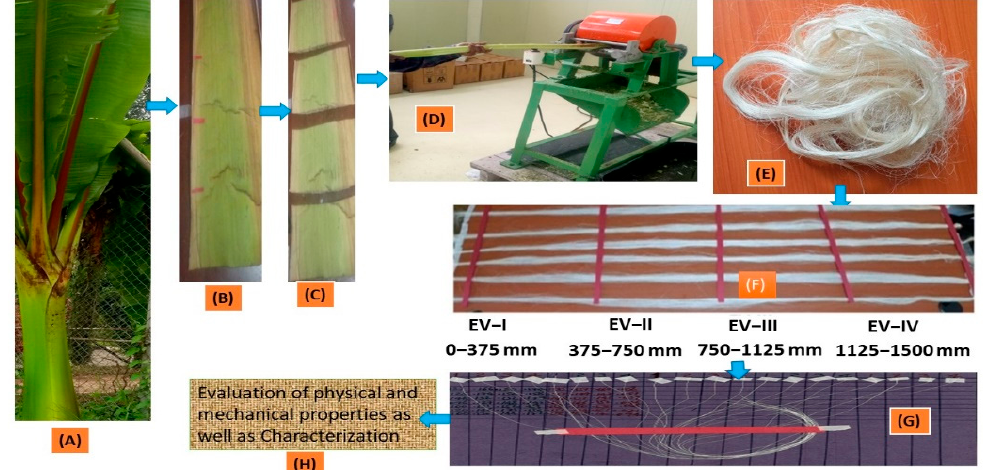
Figure 1. Enset fiber decortication process: ( A ) Enset plant; ( B ) pseudostem; ( C ) sectioned pseu- dostem; ( D ) extraction machine (Indian model); ( E ) extracted bundle fiber; ( F ) Enset bundle fiber arrangement; ( G ) leveling of sectioned Enset fiber; ( H ) evaluation and characterization.